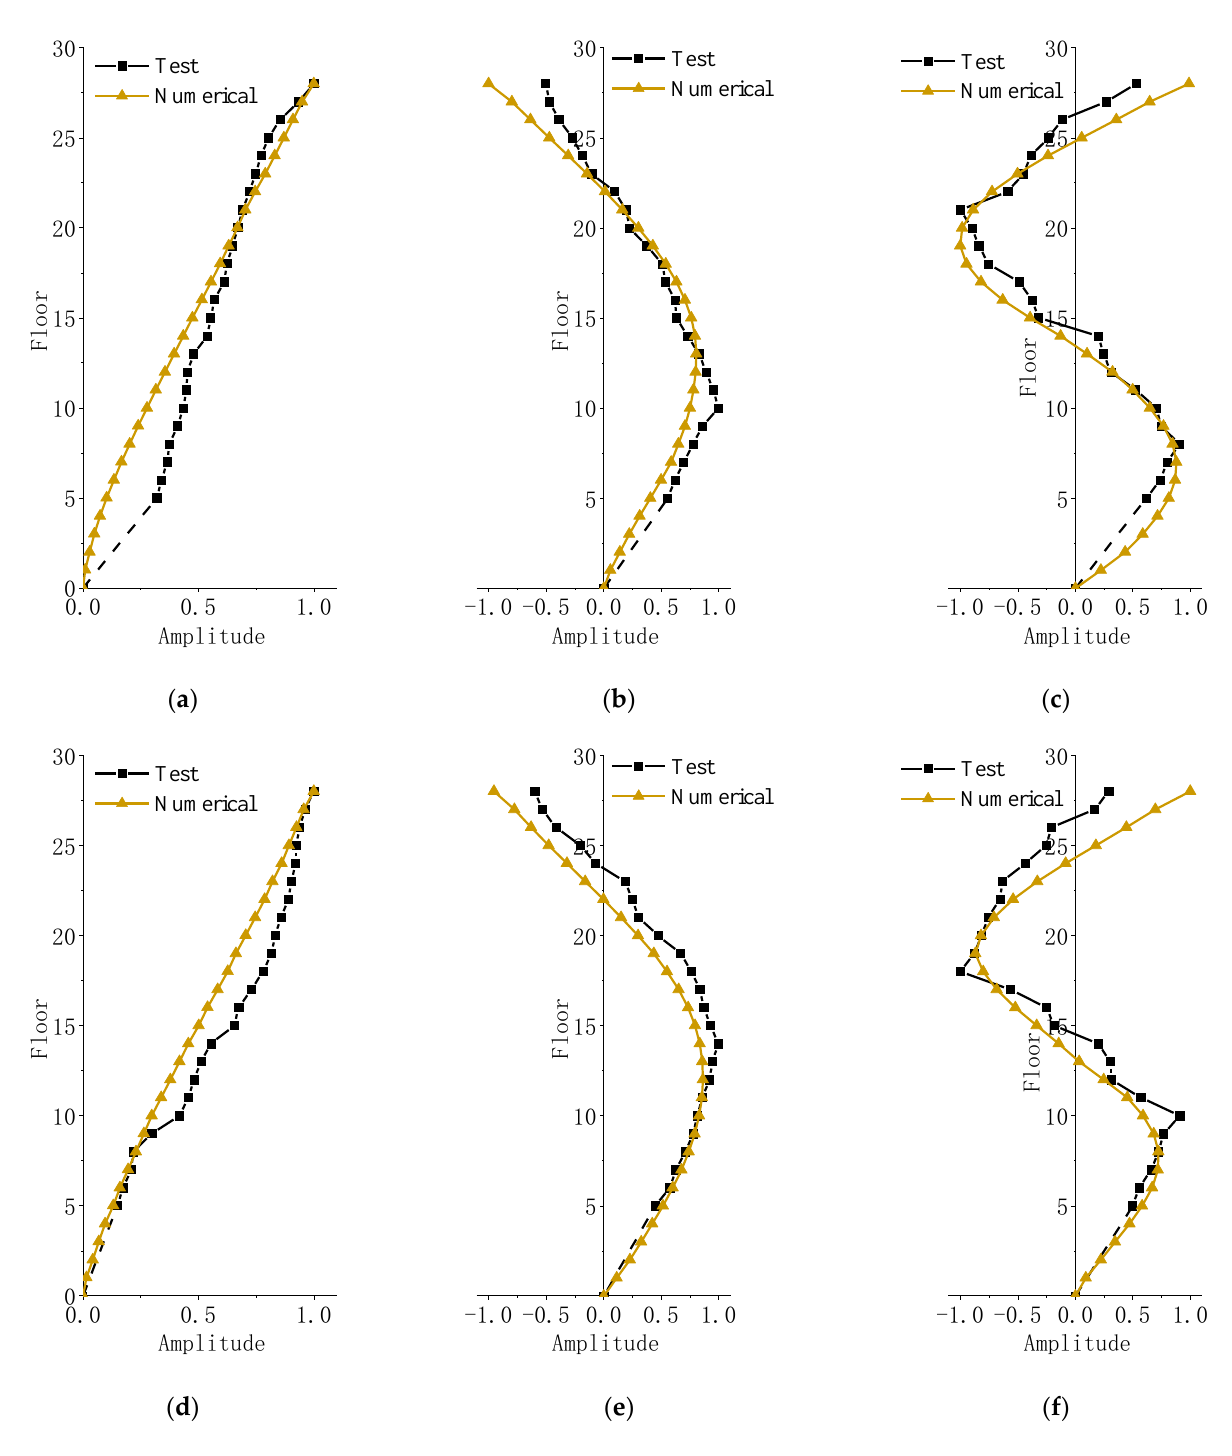
Figure 10. Comparison of the mode shapes for the numerical analysis and test results. ( a ) first-order in NS, ( b ) second-order in NS, ( c ) third-order in NS, ( d ) first-order in EW, ( e ) second-order in EW, ( f ) third-order in EW.